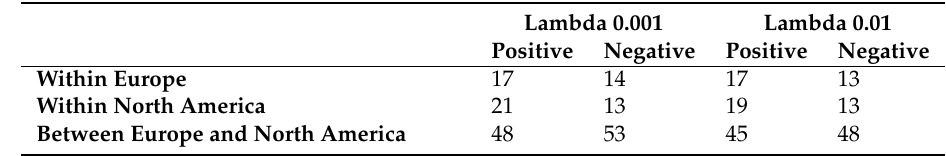
Table 3. Count of links between and within North America and